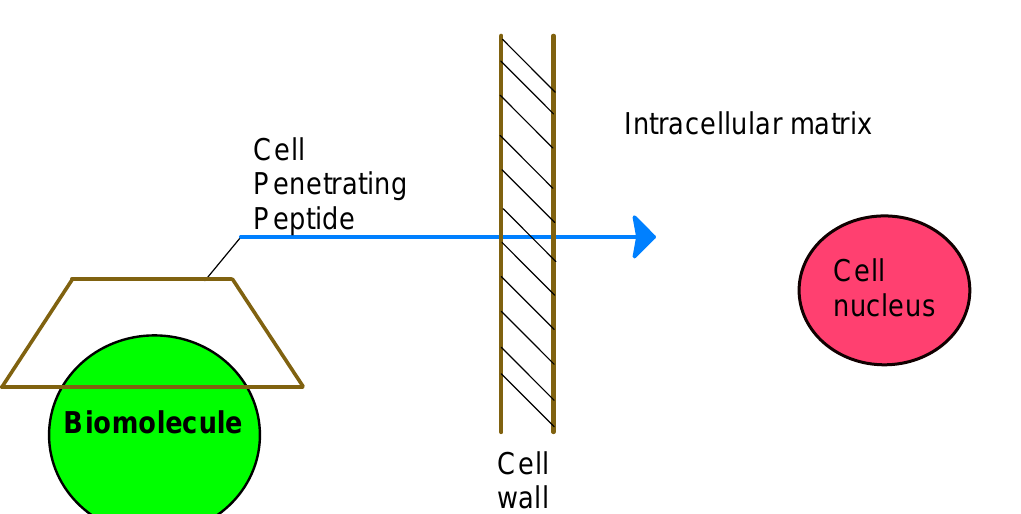
Figure 5. Intracellular delivery of biomolecules by CD-CPP.